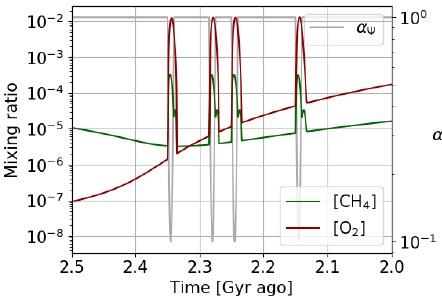
Figure 20. Oxygen and methane temporal evolution. Models with α (cid:57) reaching a factor of 0.1 on shorter timescales.